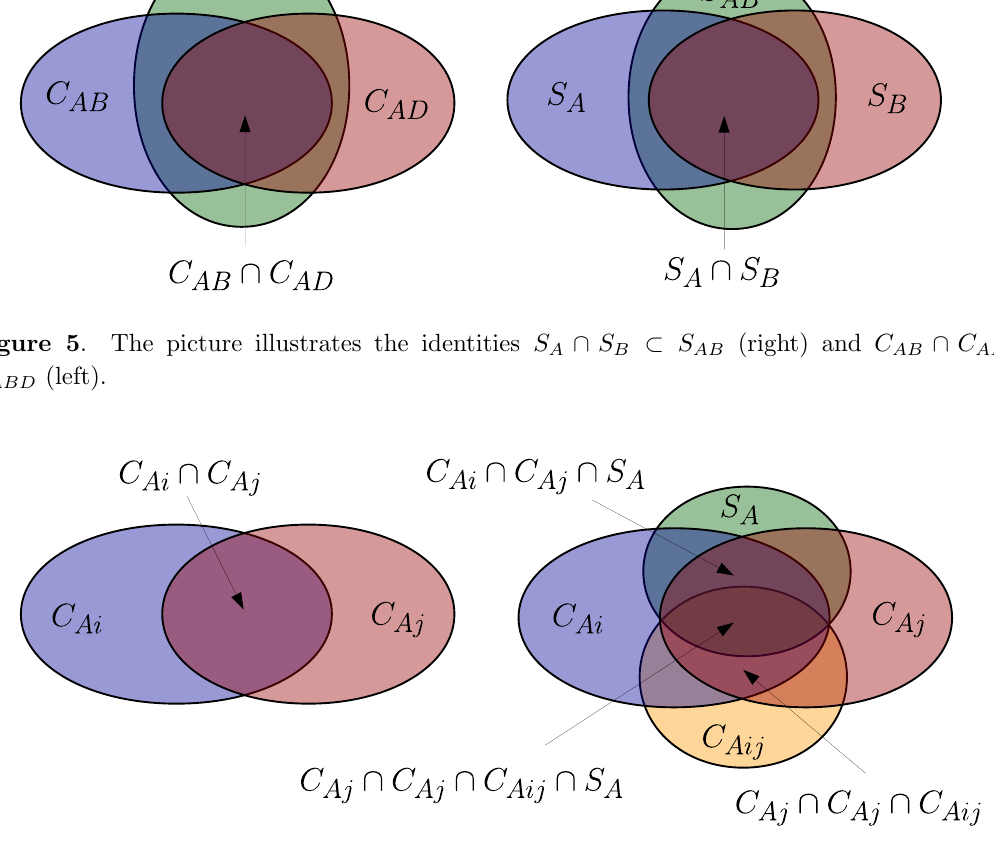
Figure 6 . The picture illustrates the identity ( C Ai \ C Aj ) (cid:26) ( C Aij [ S A